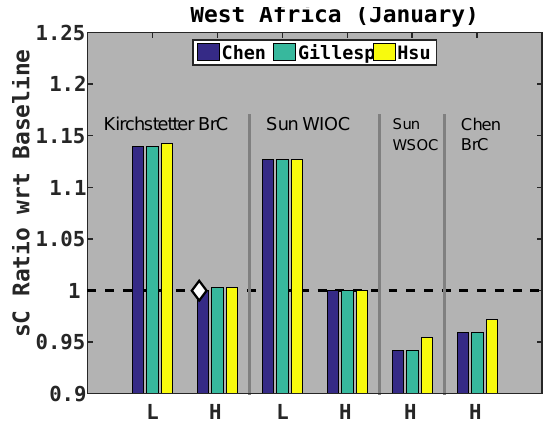
Figure 11. Relative bias associated with component refractive index uncertainty, utilizing 18 combinations of the refractive indices listed in Table 1. Each group of bars utilizes either the lowest (L) or high- est (H) sC refractive index recommended by Bond and Bergstrom (2006). Groups of bars are also labeled according to the four BrC refractive index sources in Table 1; color code denotes hematite re- fractive index source. Baseline components are denoted by the di- amond. Note that the sC bias associated with refractive index un- certainty is always less than 15%. See Table 1 for refractive index